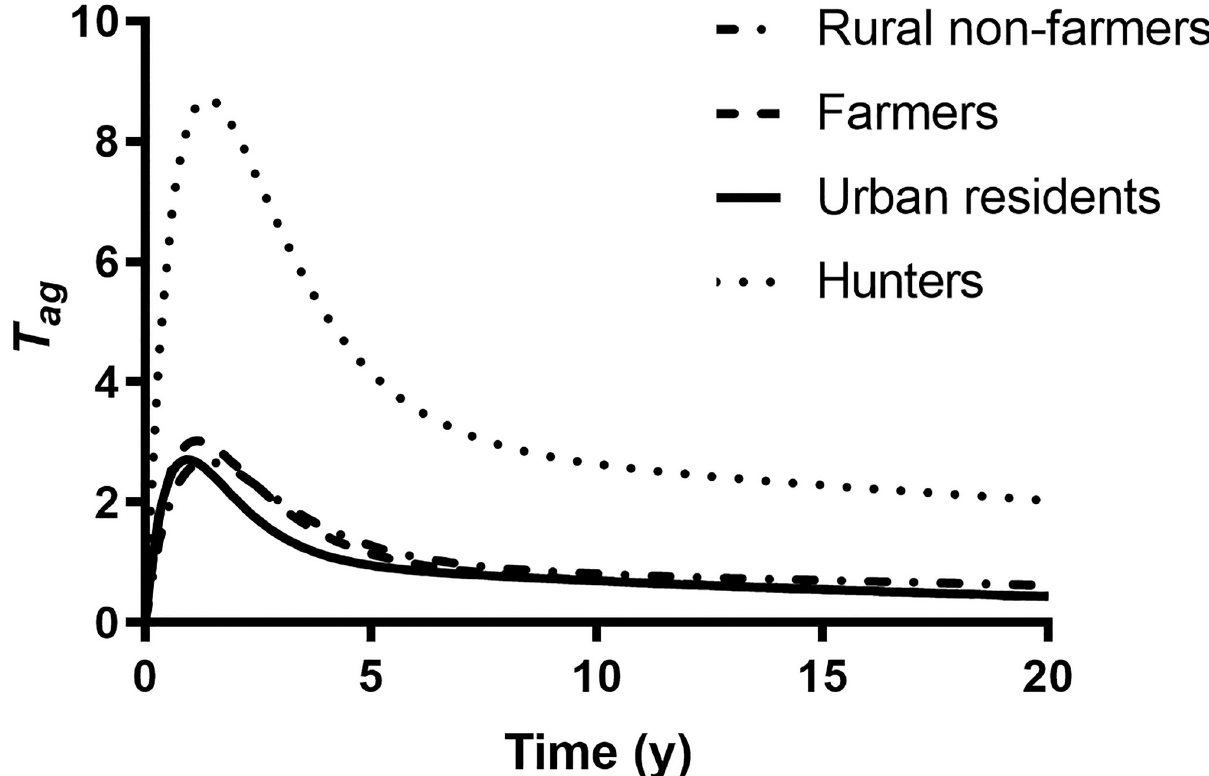
Fig 1. Time-dependent transfer of 137 Cs to various sub-populations.